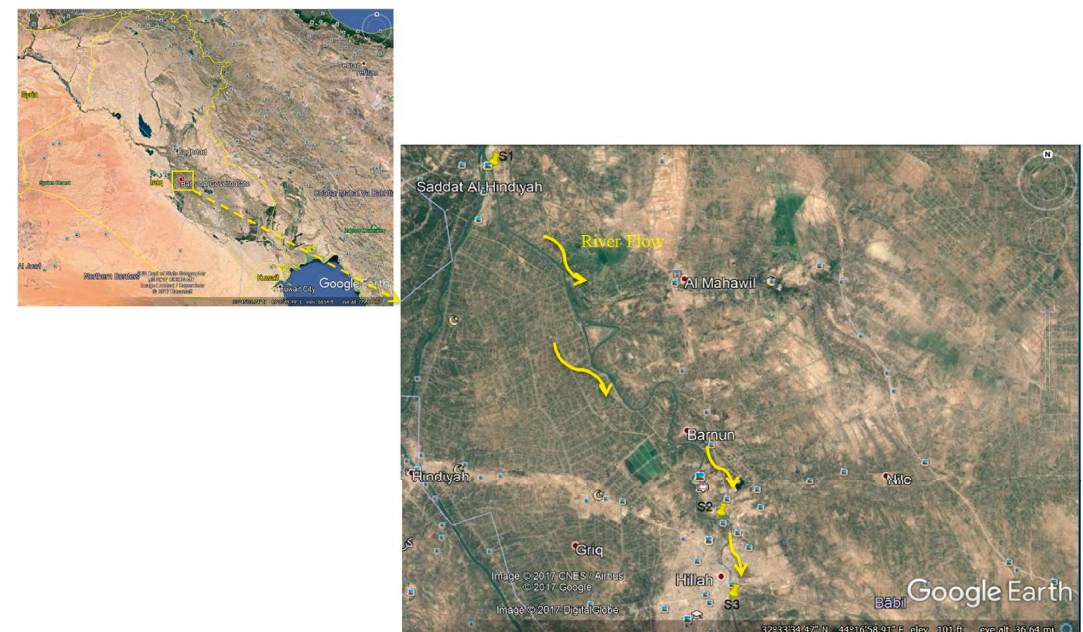
Figure 1: Locations of three sampling sites (S1–S3) along the Al-Hillah River, Babylon province,